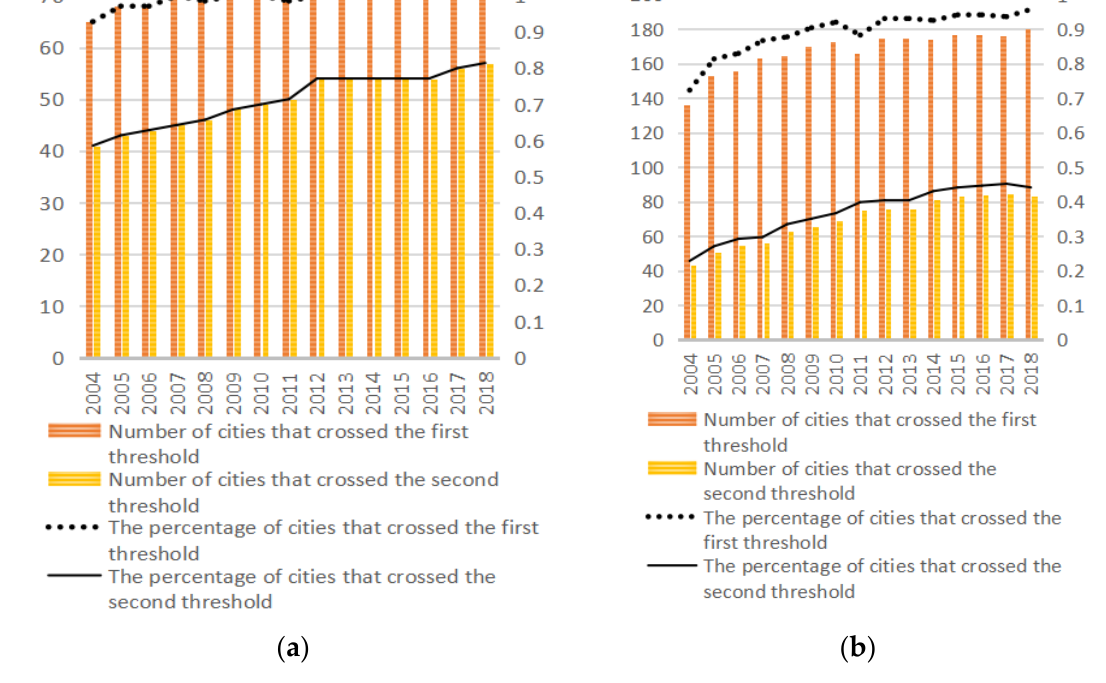
Figure 8. Comparison of threshold crossing between innovative and non-innovative cities (taking the human capital as threshold): ( a ) Innovative city, ( b ) Non-innovative city.